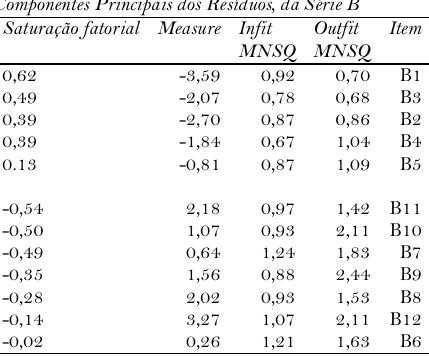
Tabela 5 Estatísticas do Fator 1, Extraído por Análise de